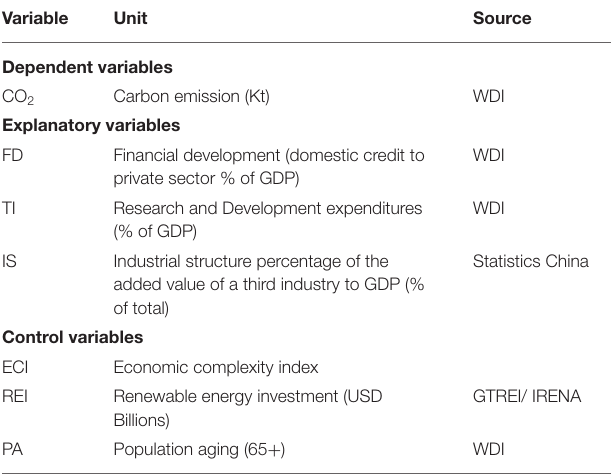
TABLE 1 | Description of